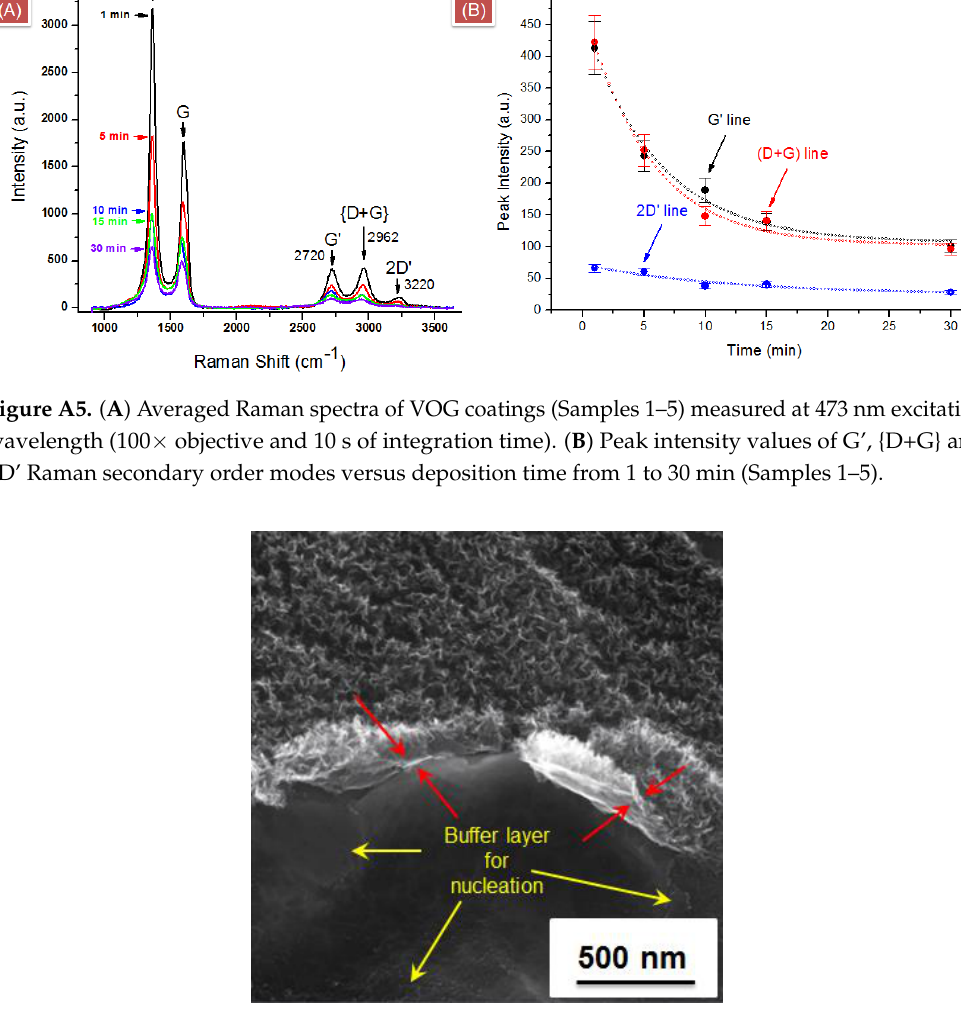
Figure A6. Representative FE-SEM image of VOG (Sample 6) prepared by the ICP CVD roll-to-roll technology.